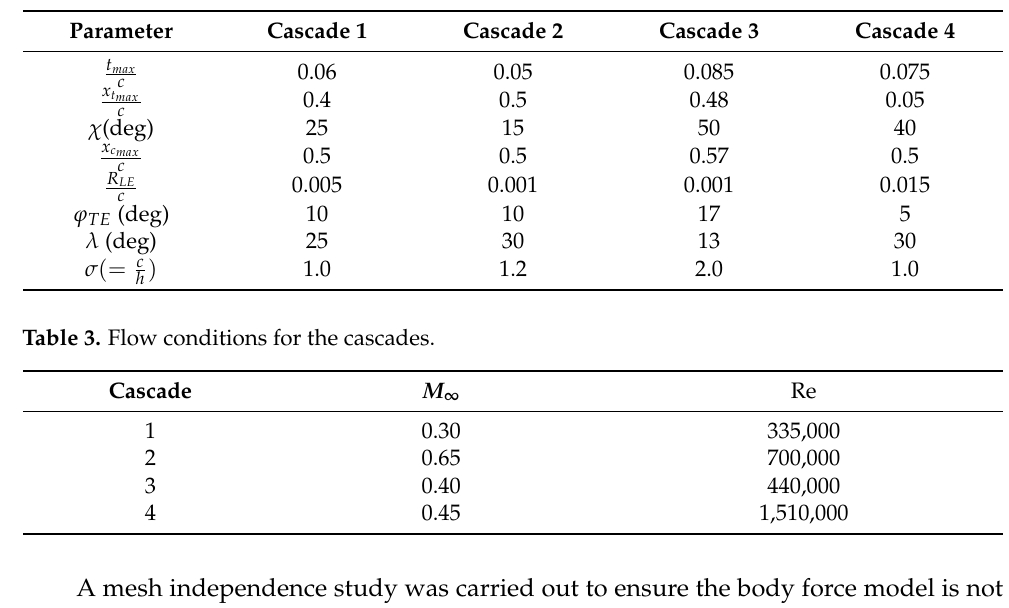
Figure 3. Studied cascades for the viscous model assessment, cascade 1 ( left ), cascade 2 ( center-left ), cascade 3 ( center-right ), and cascade 4 ( right ). Table 2. Geometry data for the cascades